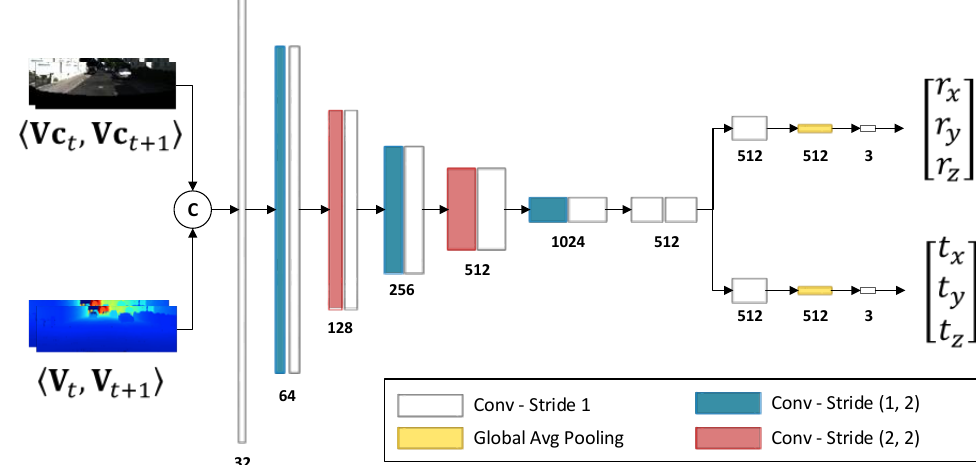
Figure 3. The architecture of our pose-estimation